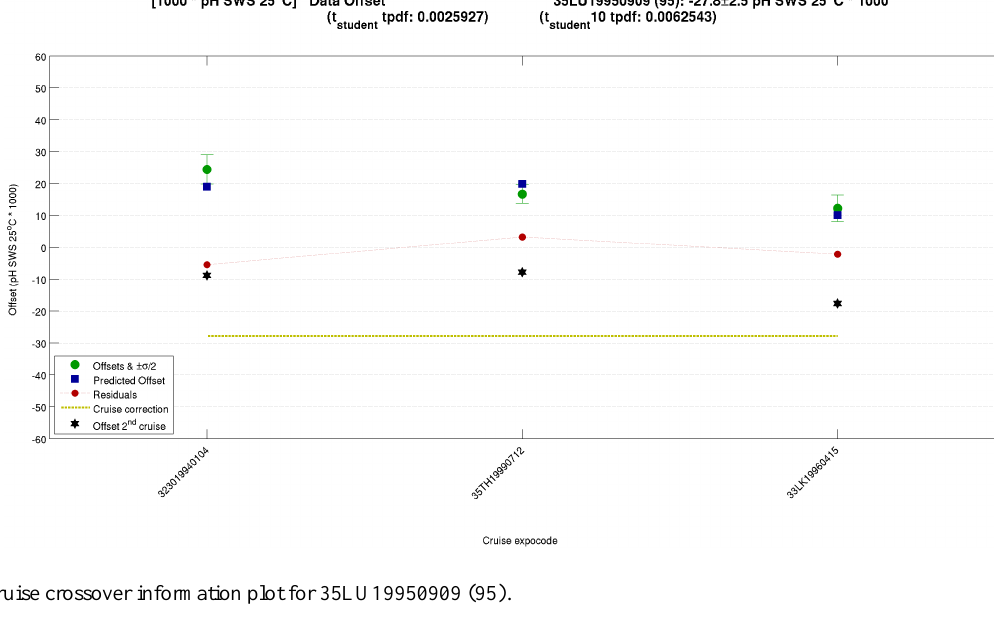
Figure 16. Cruise crossover information plot for 35LU19950909 (95).